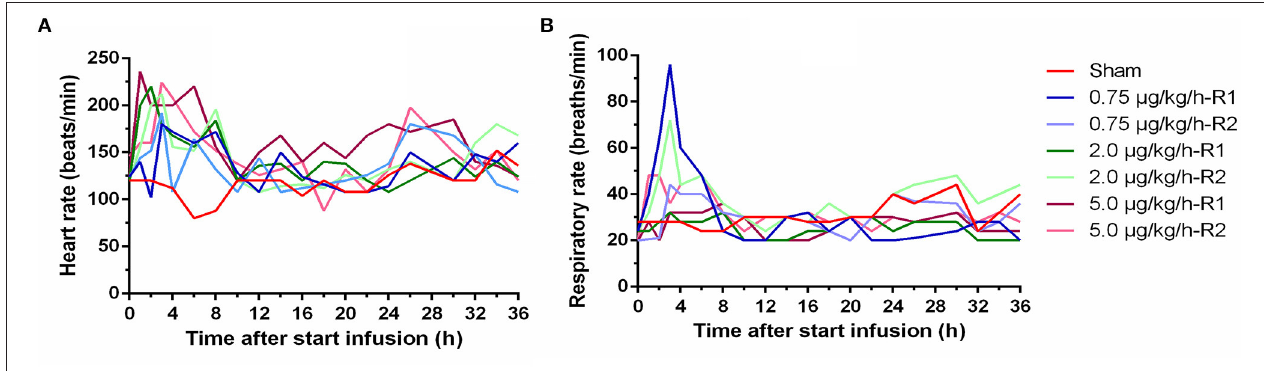
Table 1 provides an overview of the clinical symptoms occurring during the LPS